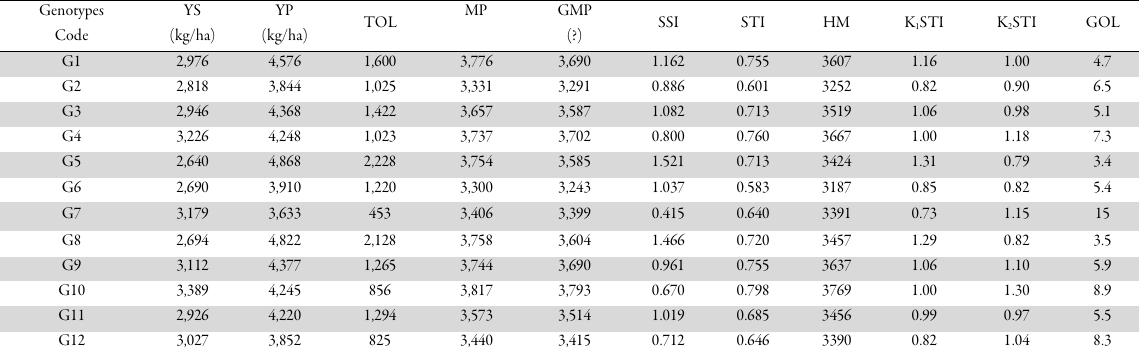
Table 4. Drought tolerance indices and two first principal components of 12 durum wheat genotypes under supplementary and rain-fed conditions Genotypes YS Code